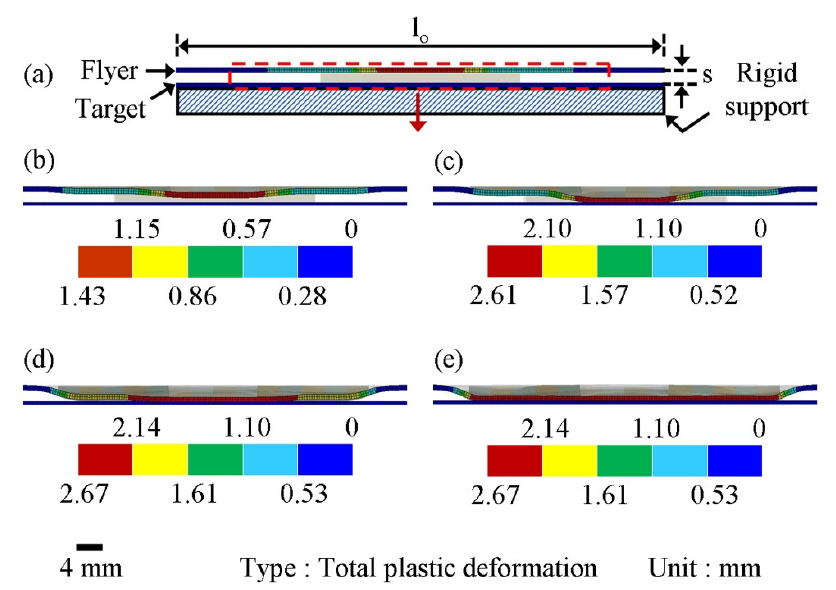
Figure 7. ( a ) Computed plastic deformation of flyer (AA5182)–target (DC04 steel) assembly with an O-shaped flat coil at successive times of ( a ) 4, ( b ) 9.6, ( c ) 12, ( d ) 16.8, and ( e ) 24 µs. Process conditions: applied energy = 13 kJ, standoff distance = 2.4 mm.